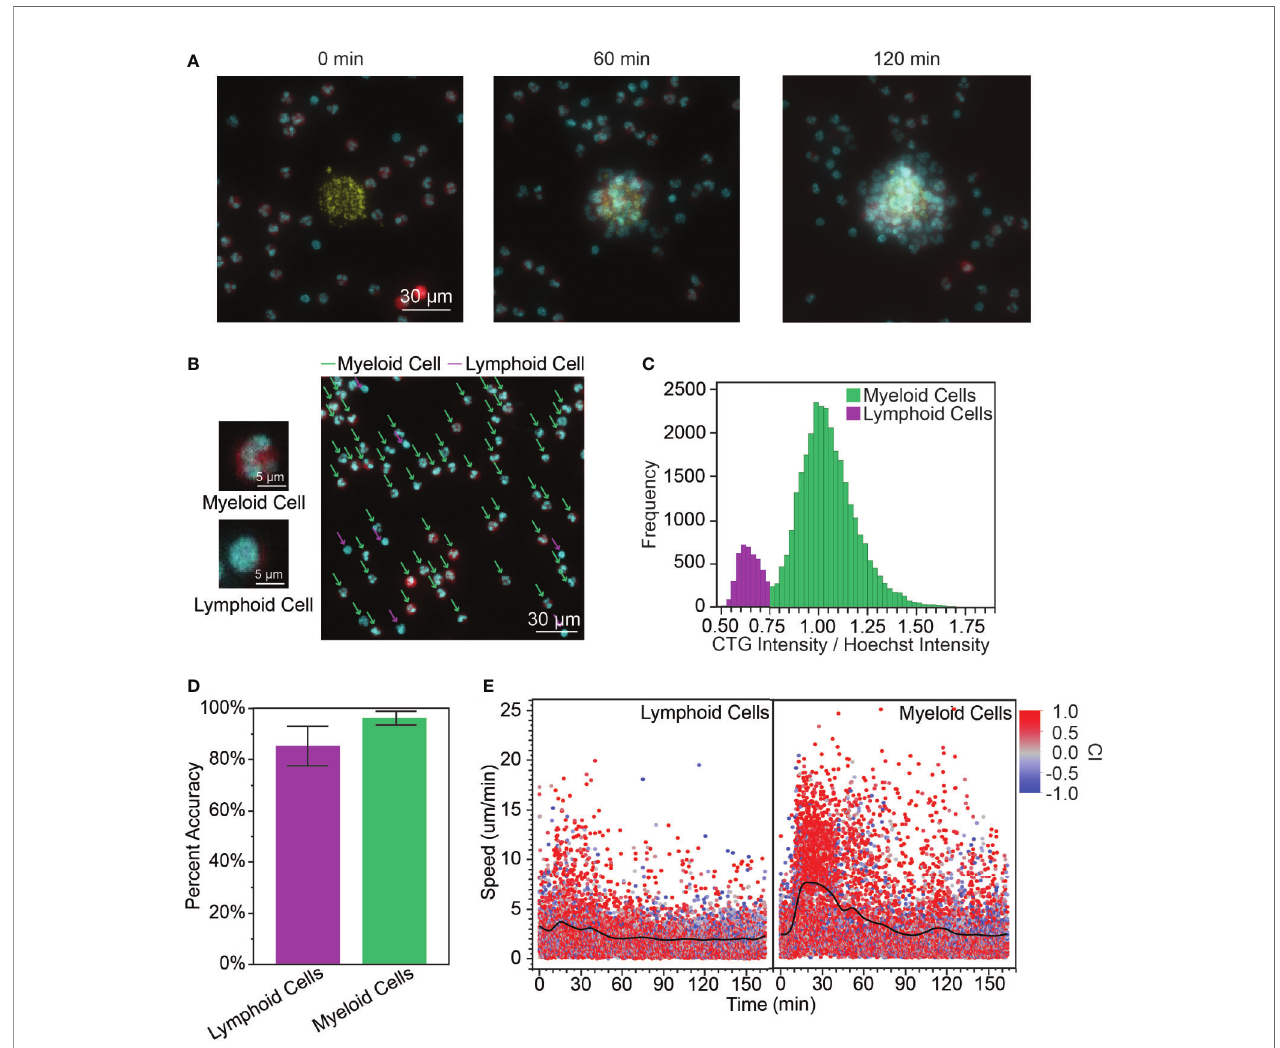
FIGURE 1 | (A) When the PBLs were fi rst added to the array of S. aureus bioparticle targets, the cells were dispersed randomly across the surface of the device (0 min). A cluster (or swarm) of PBLs grows around the bioparticle target over time (60 min, 120 min). (yellow: bioparticle target, red: PBL cytoplasm, cyan: PBL nucleus, scale bar: 30 µm) (B) Myeloid cells and lymphoid cells had distinct nuclear morphology. Myeloid cells had polymorphonuclei while lymphoid cells had large, circular nuclei and relatively little cytoplasm. The cytoplasm stain used for this experiment was CTG and the nuclear stain was Hoechst. The CTG channel was arti fi cially colored red and Hoechst cyan to facilitate visualization. [scale bars: 5 µm (left), 30 µm (right)] (C) Calculating the ratio of intensities (RI) of the cytoplasm to nuclear stains yielded a bimodal distribution, which was used to distinguish myeloid and lymphoid cells. (D) The bimodal distribution of the RI correctly identi fi ed myeloid and lymphoid cells with high accuracy (96.4 ± 2.7% for myeloid cells and 85.4 ± 7.8% for lymphoid cells, average of n = 172 leukocytes/donor, N = 3 donors). (E) The myeloid cells followed a similar speed pattern to isolated neutrophils, with increased speed during the recruitment phase of the swarm (7.32 ± 4.70 µm/min for t = 15 – 30 min, n = 1149; compared to 2.91 ± 2.75 µm/min for t = 0 – 12 min, n = 1114, p < 0.0001). Lymphoid cells exhibited only a slight increase in speed during this phase. (3.31 ± 2.86 µm/min for t = 15 – 30 min, n = 906; compared to 2.94 ± 2.42 µm/min t = 0 – 12 min, n = 909, p = 0.0027). There was no signi fi cant difference between myeloid and lymphoid cell speed during the scouting phase, while myeloid cells had signi fi cantly higher speed than lymphoid cells during the recruitment phase (p = 0.42 and p < 0.0001 for t = 0 – 12 min and t = 15 – 30 min,